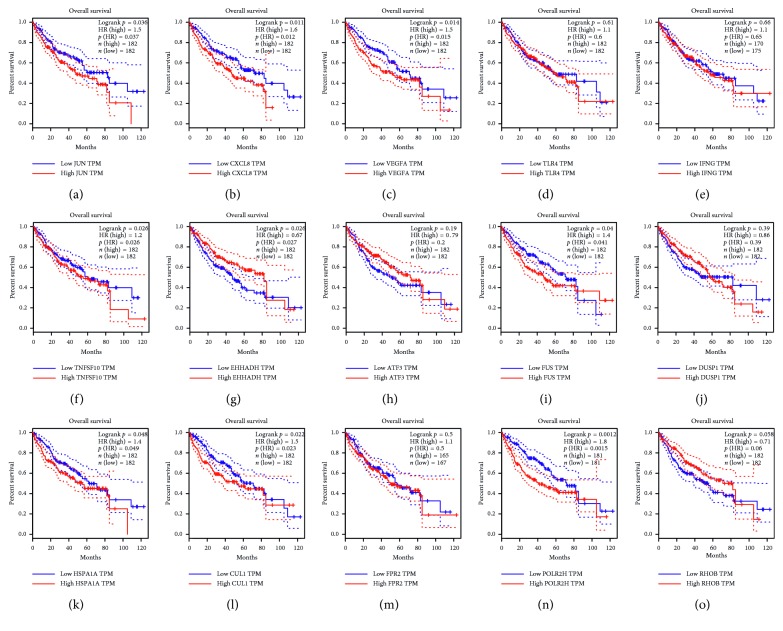
Survival curve of HCC patients of 15 hub genes. Prognostic value of 15 genes (JUN, IL8 (called as CXCL8), VEGFA, TLR4, TNFSF10, IFNG, EHHADH, ATF3, FUS, DUSP1, HSPA1 A, CUL1, FPR2, POLR2H, and RHOB) in HCC. P < 0.05 was regarded statistically different.